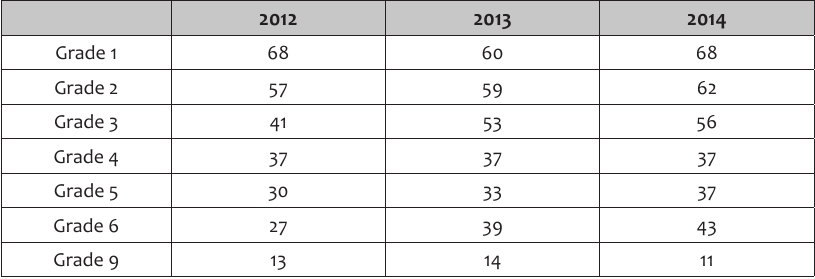
Table 1: Average mathematics scores in ANA, 2012-2014 (Source: Own calculations from ANA